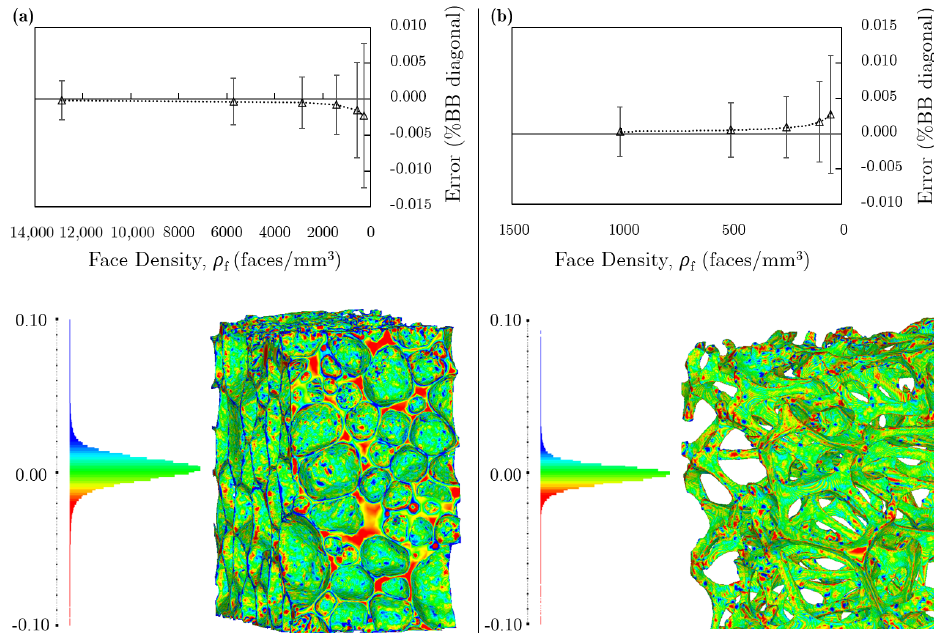
Figure 12. Average distance from a reference mesh and visual representation of the distance from a reference mesh ( a ) of the cut closed-cell foam specimen and model with 500 thousand faces, i.e., 286 faces per mm 3 and a 99% reduction, ( b ) and of the cubic open-cell foam specimen and model with 500 thousand faces, i.e., 50 faces per mm 3 and a 98%